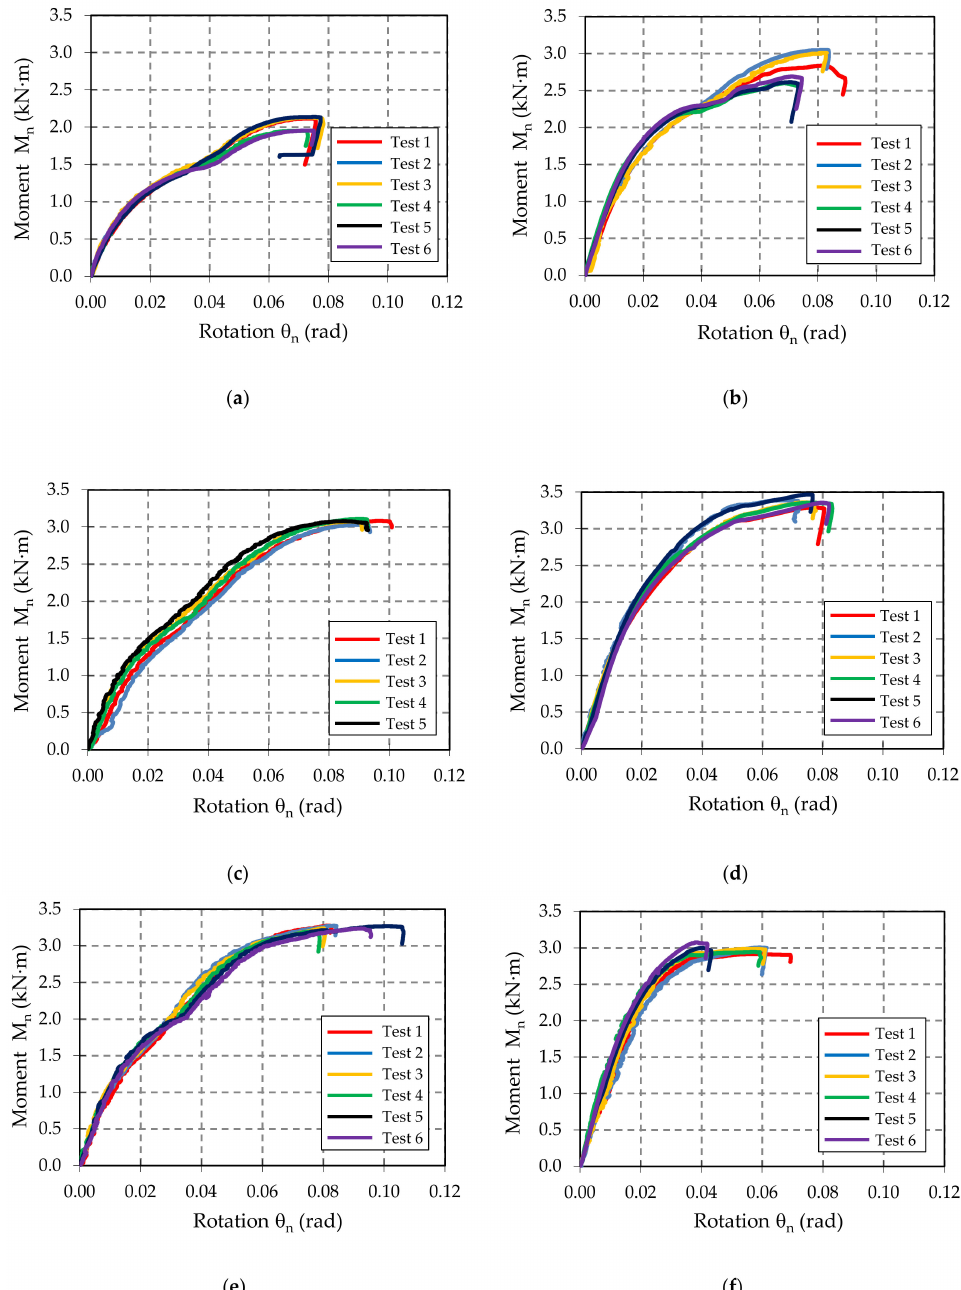
Figure A3. Moment-rotation (M n – θ n ) curves recorded for the beam-connector-upright assemblies: ( a ) C-I-4L, ( b ) C-I-5L, ( c ) C-II-4L, ( d ) C-II-5L, ( e ) C-III-4L, and ( f )